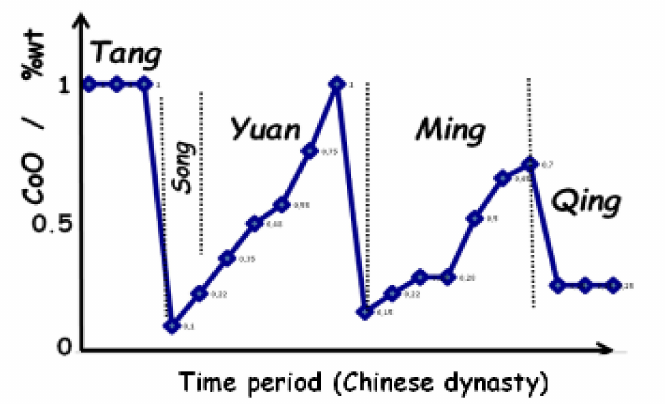
Figure 3. Typical CoO content (wt.%) in Chinese glazes (after data from [162]). Tang glaze is lead- based and hence a very homogeneous glaze; Song, Yuan and Ming glazes show various hues of blue and hence varying cobalt content; Qing blue overglaze is also